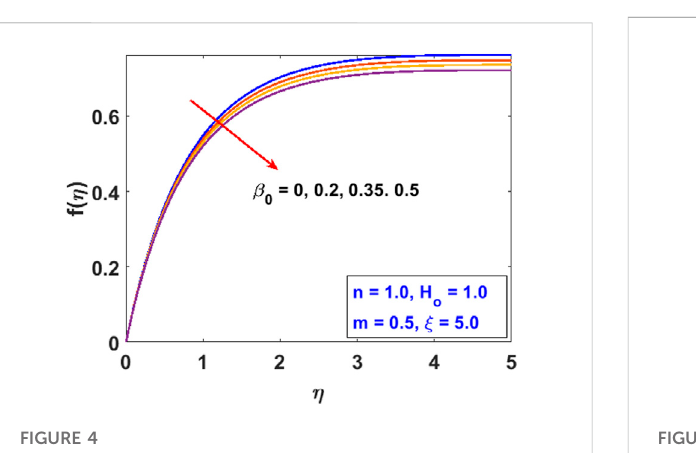
FIGURE 7 Effects of ξ on f ′ ( η